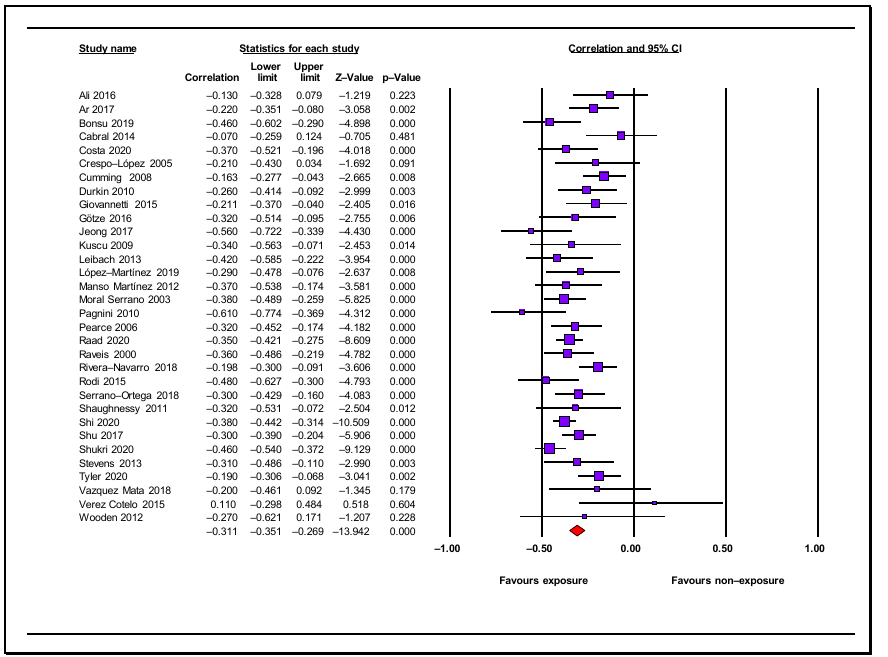
Figure 2. Forest plot for perceived social support and anxiety symptoms in informal carers [25,42– Figure 50,52,54–74].